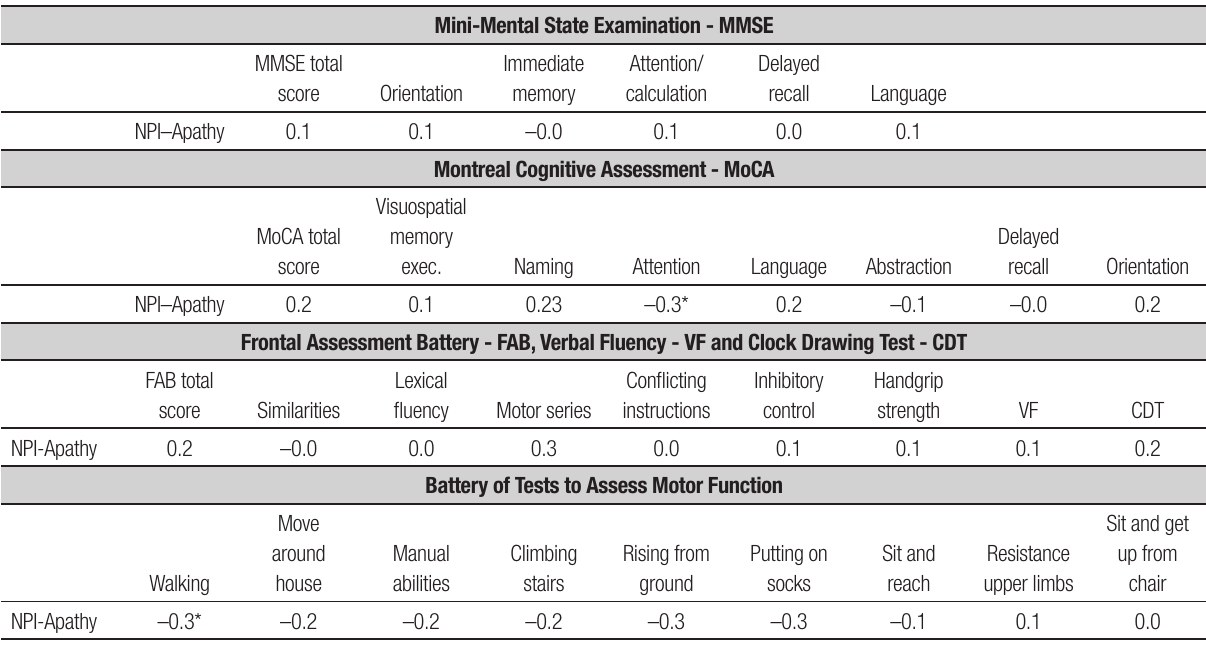
Table 2. Relationship between apathy, as measured by NPI-apathy, and MMSE tests, MoCA, VF, CDT, WAL, MH, MA, CS, RG, PS, SR, RUL, and SGC for 37 study